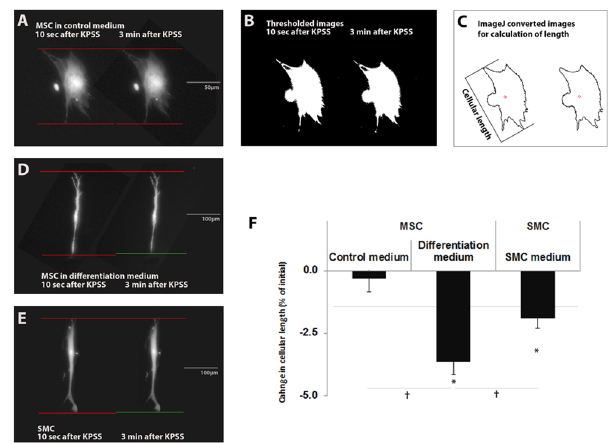
Fig 10. Contraction of differentiated MSCs and bladder SMCs. Contraction was measured by quantifying changes in cellular length. MSCs of three different donors were cultured in control medium or differentiation medium for 7 days and compared to bladder SMCs. To illustrate the process of determining cellular length, representative images of Calcein-stained MSCs in control medium 10 seconds and 3 minutes after KPSS addition are shown in (A). The red lines are reference lines for assessing cellular dimensions at each time point. The green line indicates a change in the cell length. The images generated through